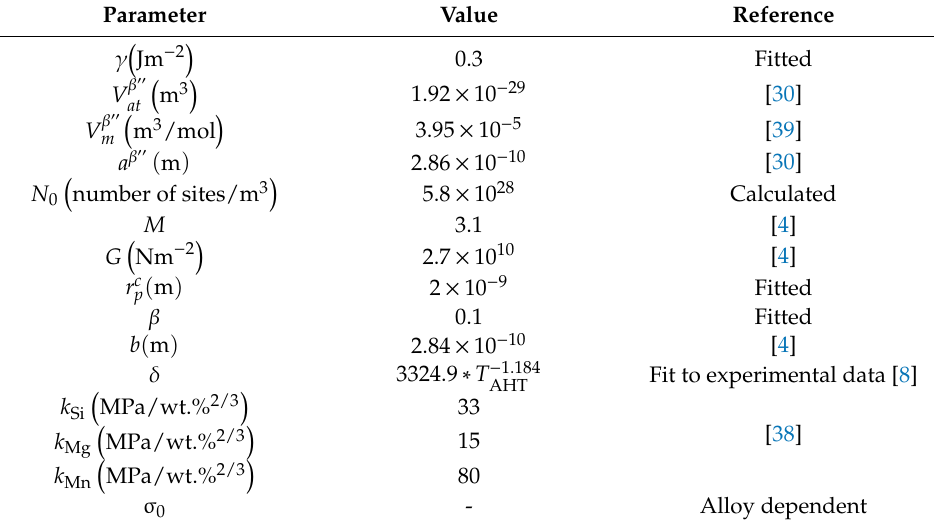
Table 3. Parameters used in precipitation and strength